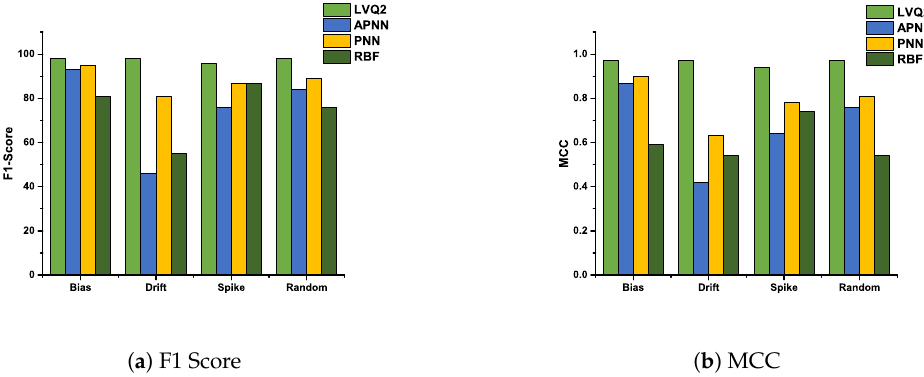
Figure 11. F1-Score and MCC value of various NNs for all faults at 10 % fault rate.